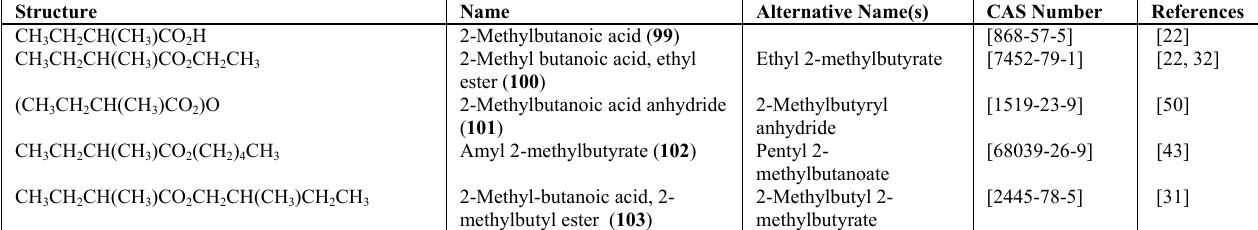
Table 7. Branched Aliphatic Carboxylic Acids, Esters and